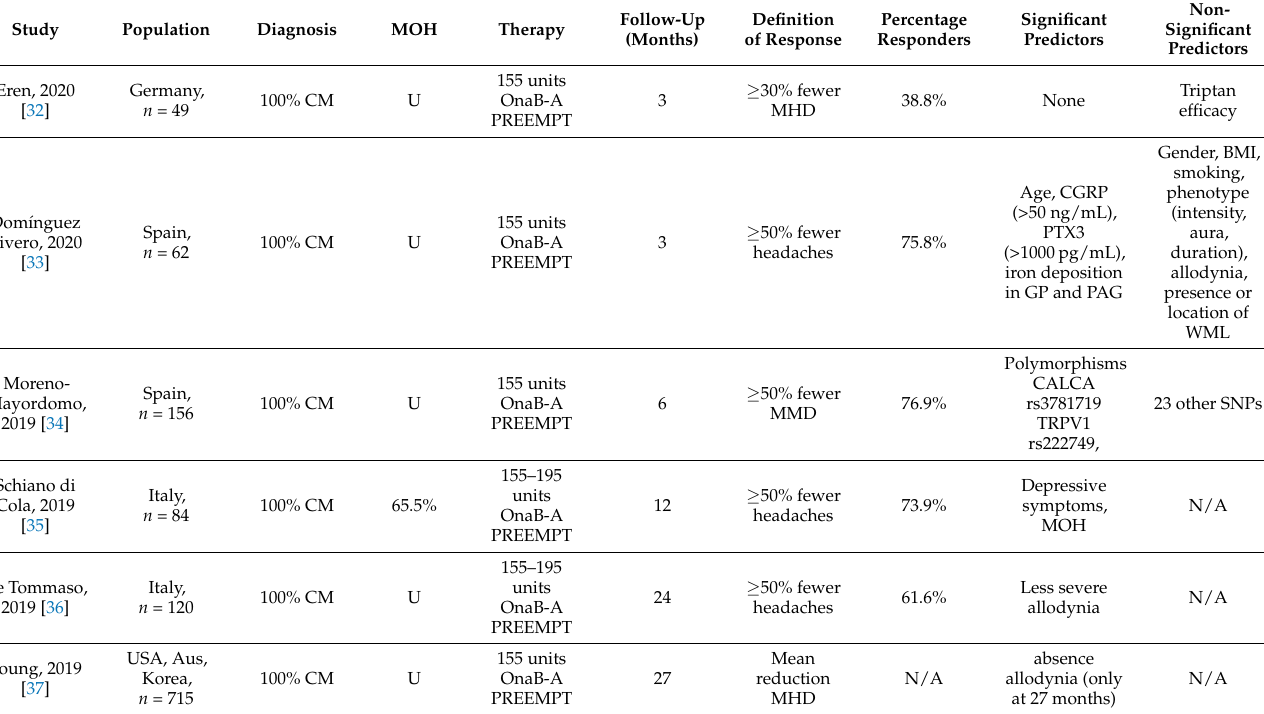
Table 1. Predictors of efficacy of onabotulinumtoxinA in chronic migraine.